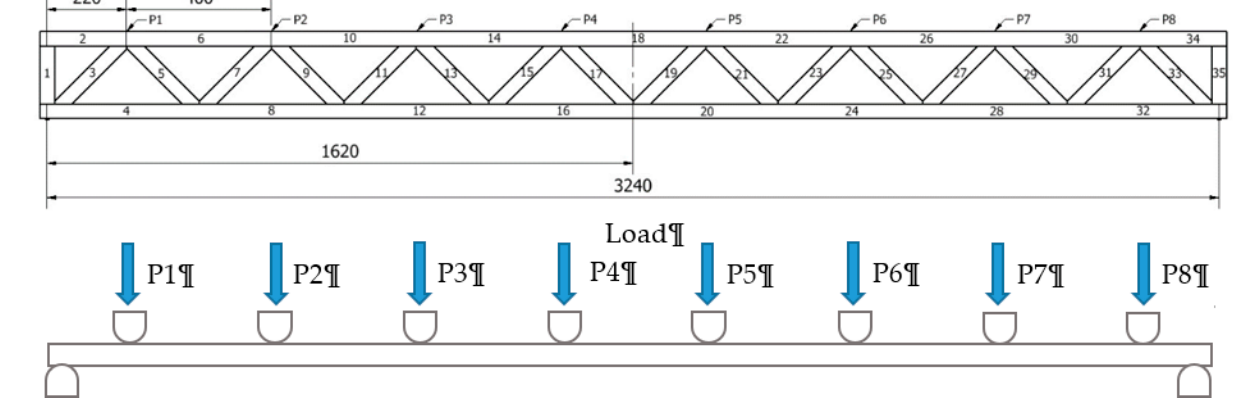
Figure 2. Truss loading scheme at each node (P i = P=2,78 kN)—scheme A.